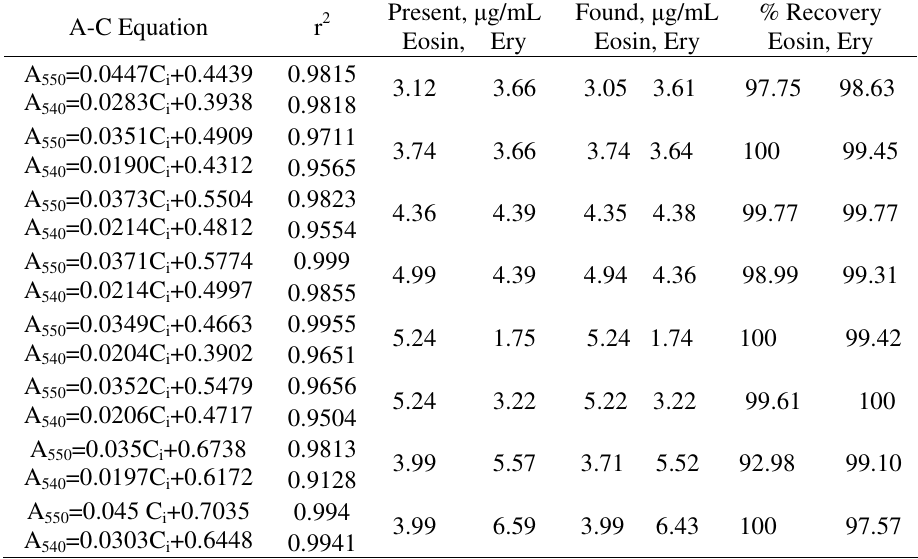
Table 1. Results of several experiments for analysis of eosin and erythrosine (Ery) in synthetic samples by HPSAM A-C Equation